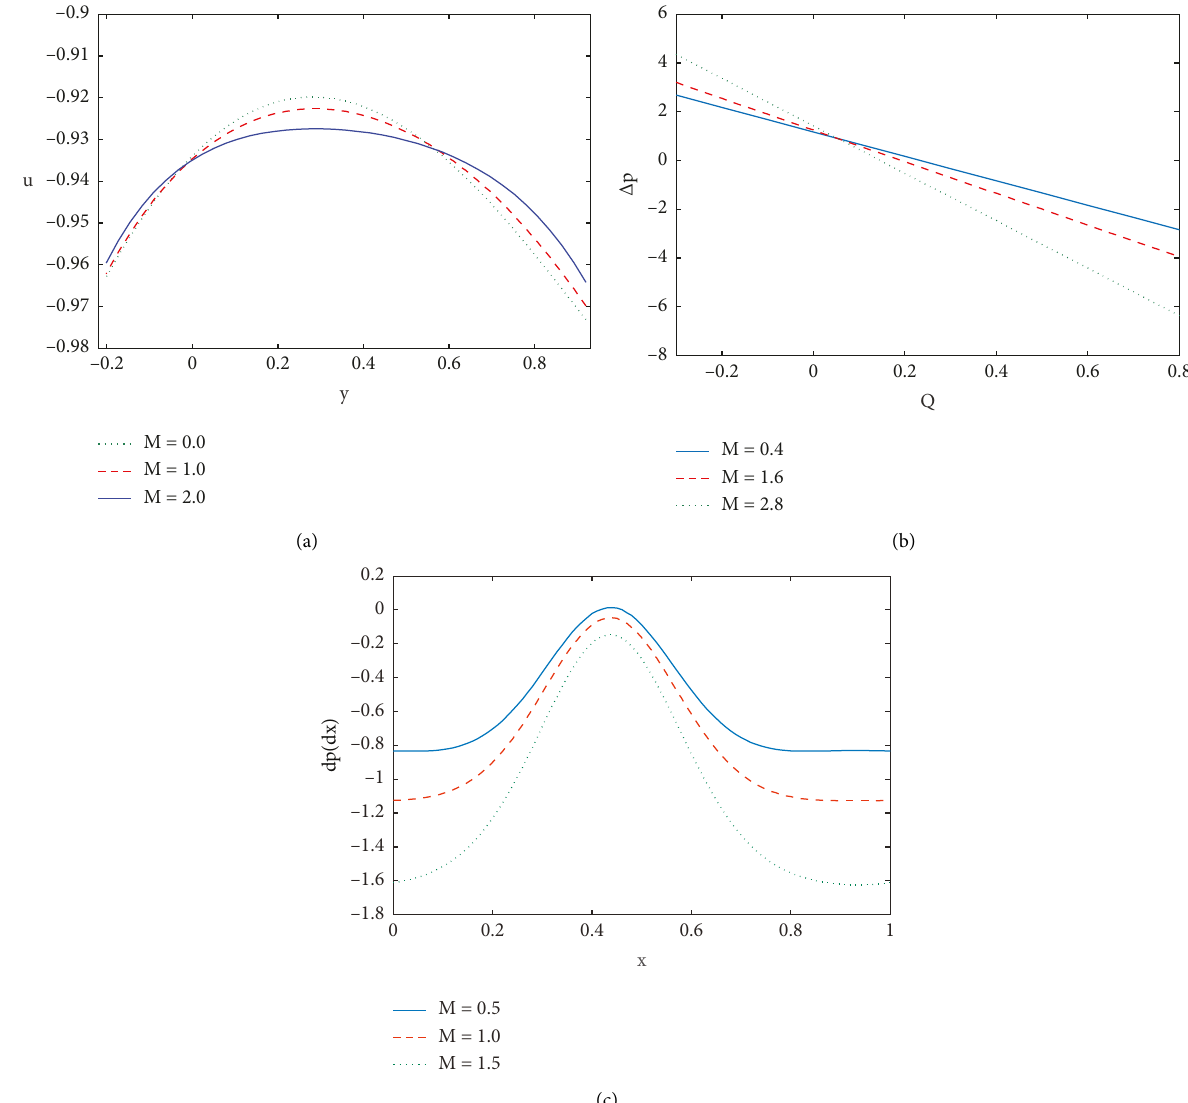
Figure 2: Influence of the Hartmann number ( M ) on u Δ p and dp /